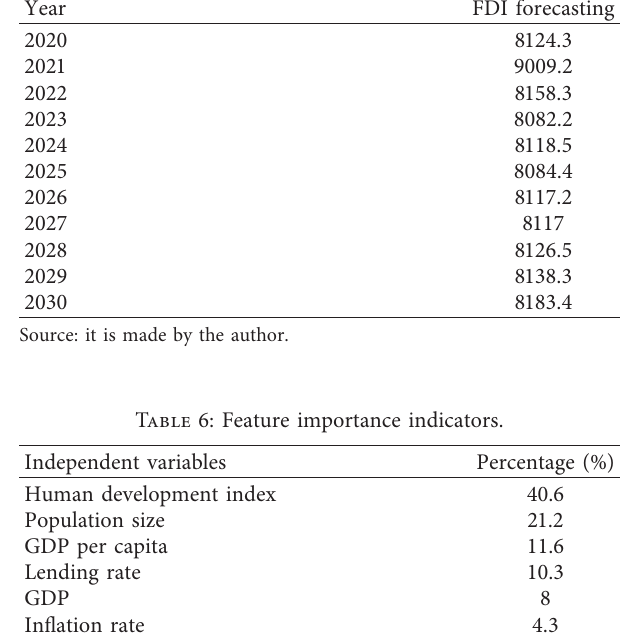
Table 5: Egypt FDI inflow prediction in the period (2020–2030).